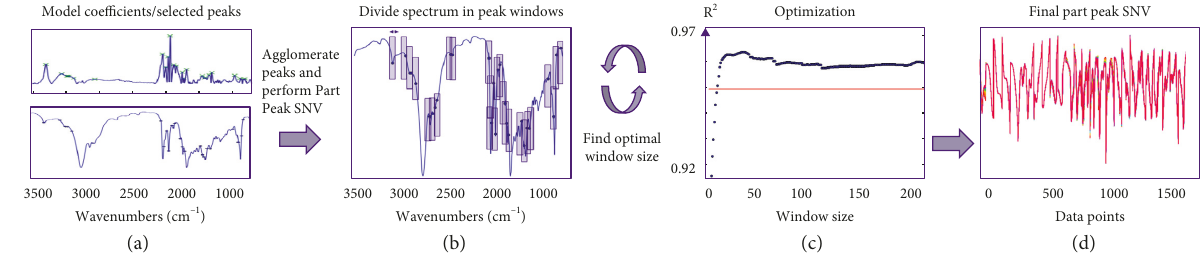
Figure 7: Demonstration of the workflow and optimization process for Dynamic Localized SNV. (a) Picked peaks of normalized absolute coefficient vector and indication of the POIs in one spectrum, (b) spectrum separation according to agglomerated peaks, (c) optimization process in order to find optimal window size around the POIs, and (d) optimized